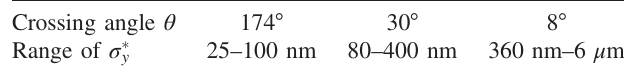
TABLE II. Dynamic range of the IPBSM. Crossing angle θ 174°